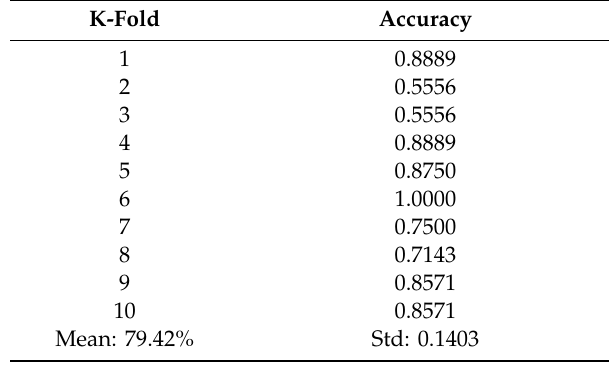
Figure 15. The accuracies achieved by the Folds after performing 5-Fold Cross-Validation on the LR model. Table 2. Accuracies achieved by performing 10-Fold Cross-Validation on the LR model.